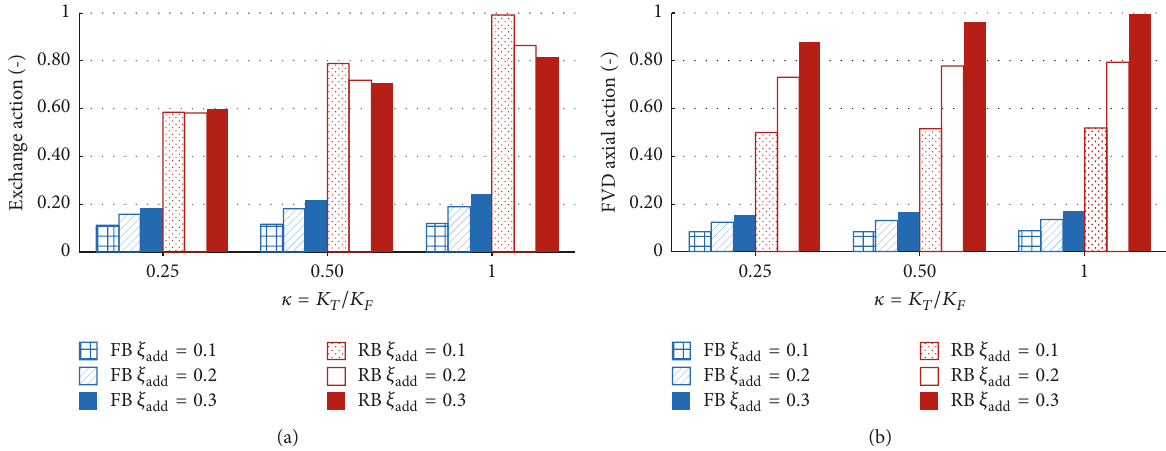
Figure 13: Results of the parametric analysis for the FB and RB configurations in terms of (a) exchange forces between one external frame and the existing frame and (b) sum of the forces of the